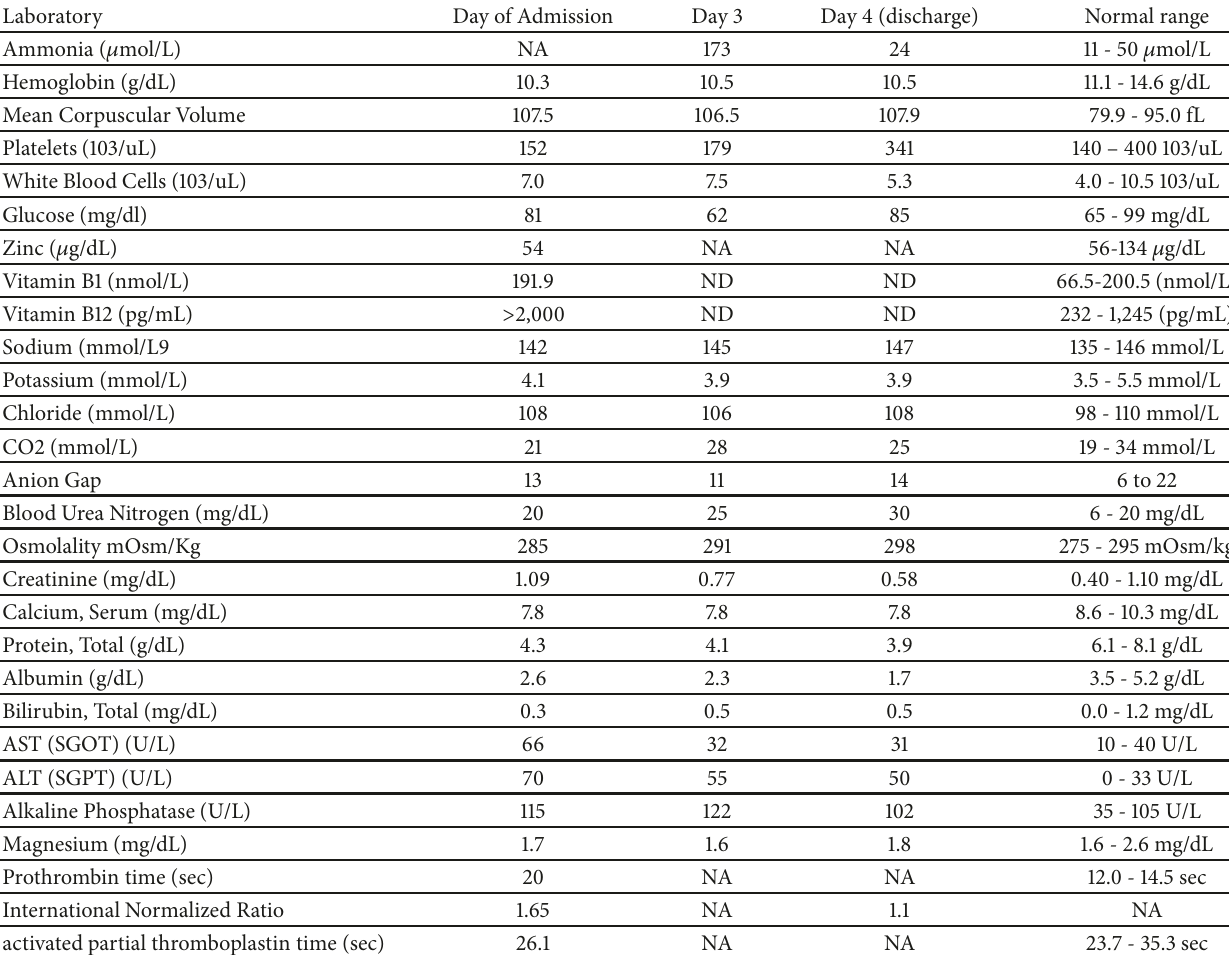
Table 1: Laboratory findings during